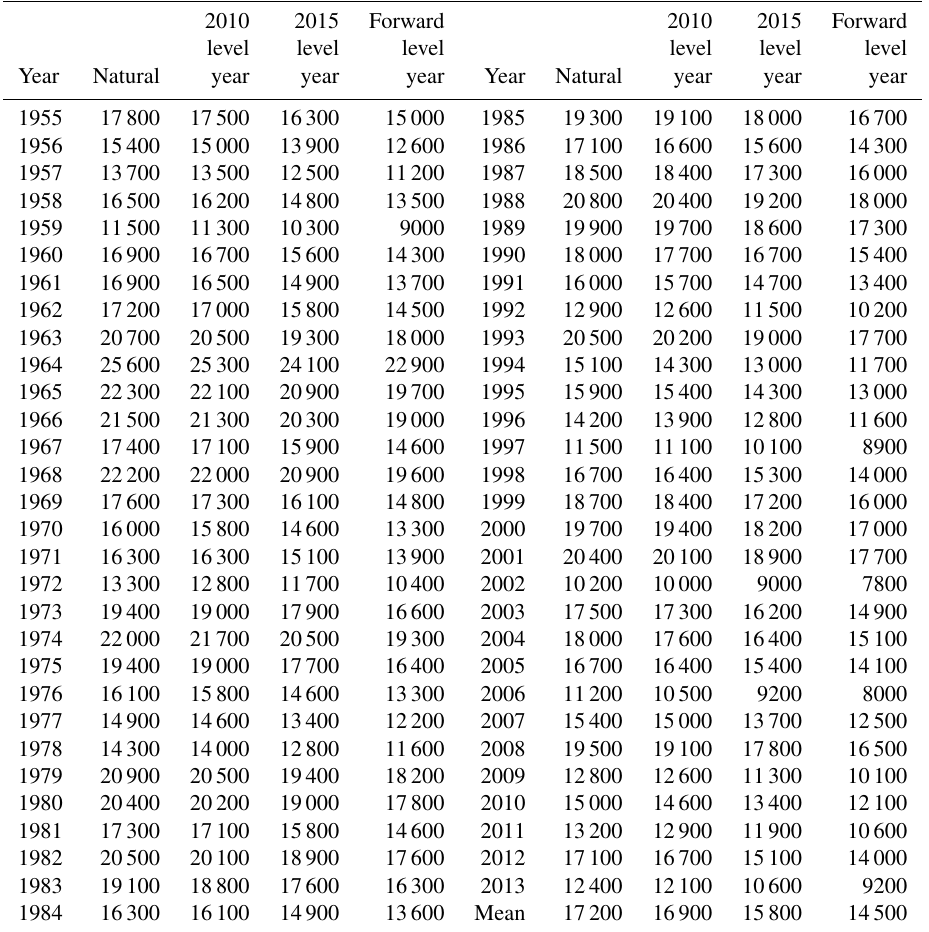
Table 3. Mean flow of Yichang hydrological station from September to November in different level years (m 3 s − 1